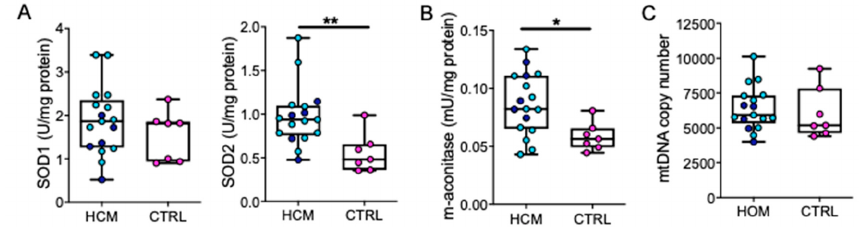
Figure 2. Reactive oxygen species (ROS) scavenging enzymes’ activity and mtDNA quantification of SOD1 ( A ), SOD2 ( B ) and (m-)aconitase ( C ) activities in tissue extracts are plotted, showing high activity of SOD1 in both groups, and the activation of SOD2 and (m)-aconitase in HCM. The absence of difference between HCM and CTRL in total mtDNA copy number into myocardial tissue is displayed ( D ). Data from 17 HCM and seven CTRL samples are presented as boxes (min to max) and dots indicate single sample values (mean values from three replicates). Dark blue dots indicate HCM patients with mutation, light blue dots those without. Unpaired t-test is applied. Significant differences are shown as * p < 0.05 and ** p < 0.01.